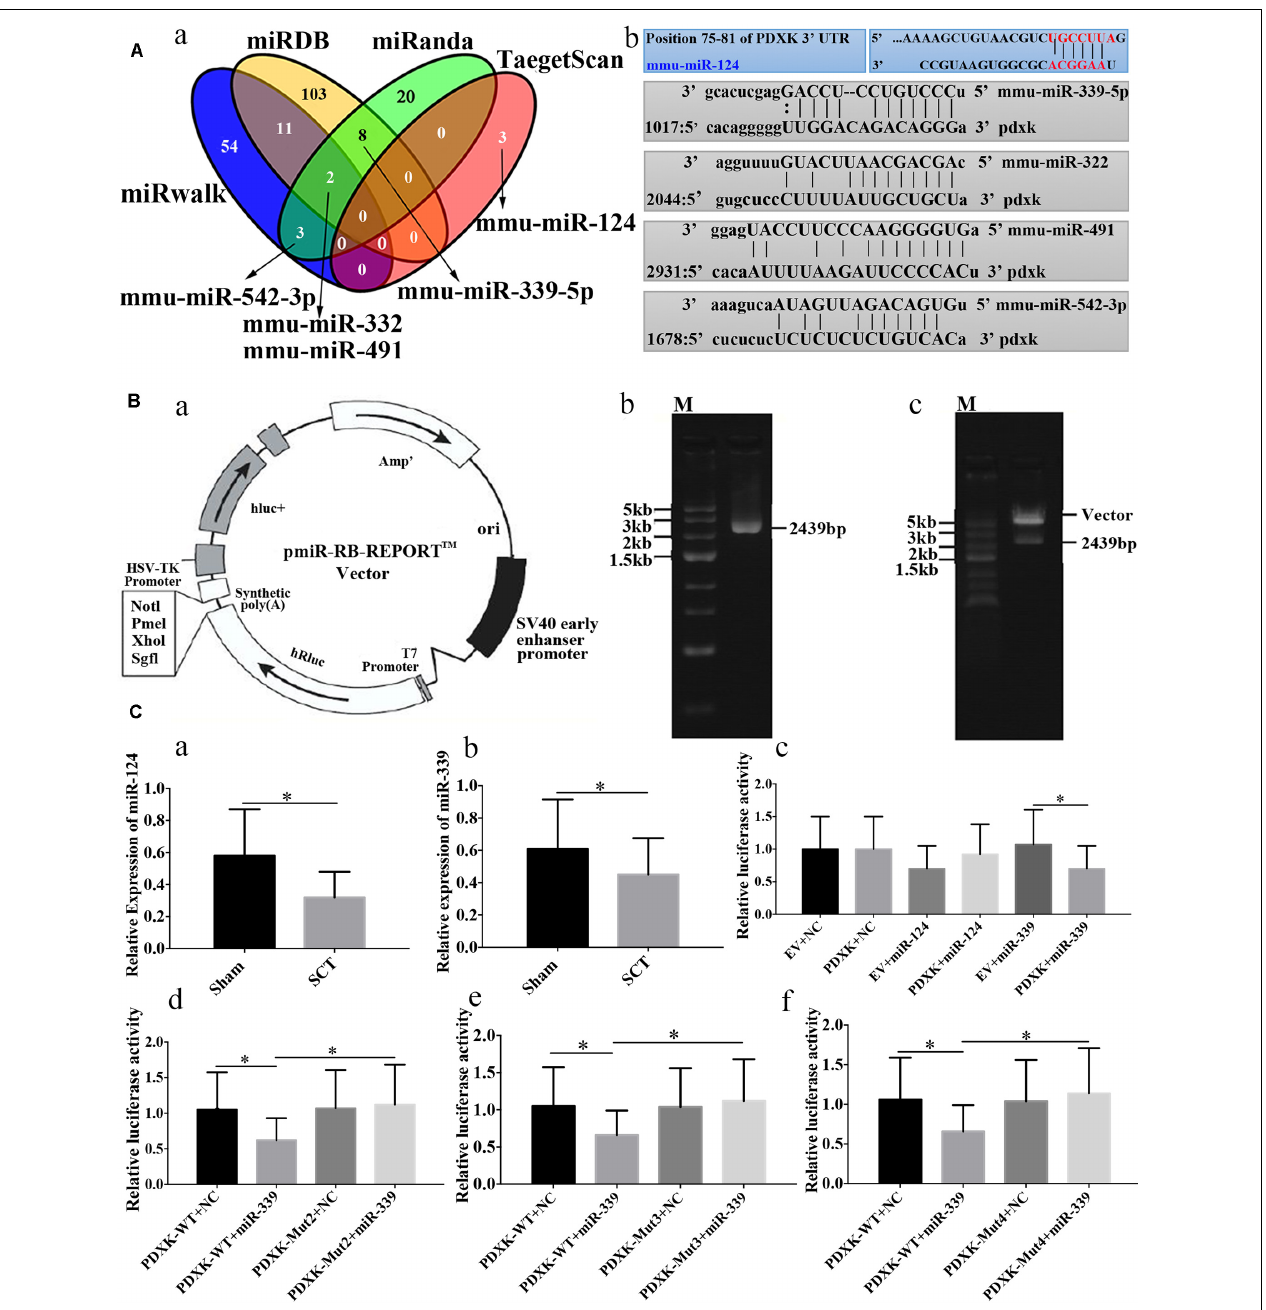
FIGURE 4 | Bioinformatic prediction on PDXK regulated by miRNAs and the validation of their relation. (A-a) The map of bioinformatics prediction through TargetScan (http://www.targetscan.org/vert_72/docs/help.html), miRDB (http://www.mirdb.org), miRanda (www.microrna.org), and miRwalk (http://mirwalk.umm.uni-heidelberg.de) databases; venny2.1 (http://bioinfogp.cnb.csic.es/tools/venny/index.html) was implemented to acquire the intersecting results of these four databases. Mmu-miR-124, mmu-miR-322, mmu-miR-491, mmu-miR-339-5p and mmu-miR-542-3p were selected as the candidate miRNAs. (A-b) The alignments of predicted microRNAs and PDXK. (B-a) Vector information for the vector of PDXK 3 (cid:48) UTR. (B-b) One percent agarose electrophoresis analysis of PCR products that amplified PDXK 3 (cid:48) UTR. M, marker5000. (B-c) Validation of plasmid enzyme digestion. M, marker5000. (C-a) Verification of miR-124 expression in cerebral cortex of rats with SCT at 28 days. (C-b) Verification of miR-339 expression in cerebral cortex of rats with SCT at 28 days. (C-c) The luciferase assay results in EV + NC, PDXK + NC, EV + miR-124, PDXK + miR-124, EV + miR-339, and PDXK + miR-339 group. (C-d) The luciferase assay results in PDXK-WT + NC, PDXK-WT + miR-339, PDXK-Mut2 + NC, and PDXK-Mut2 + miR-339 group. (C-e) The luciferase assay results in PDXK-WT + NC, PDXK-WT + miR-339, PDXK-Mut3 + NC, and PDXK-Mut3 + miR-339 group. (C-f) The luciferase assay results in PDXK-WT + NC, PDXK-WT + miR-339, PDXK-Mut4 + NC, and PDXK-Mut4 + miR-339 group. Data were exhibited as mean ± SD; * P < 0.05. PDXK, pyridoxal kinase; SCT, spinal cord transection; EV, empty vector; NC, negative control; WT, wild type.